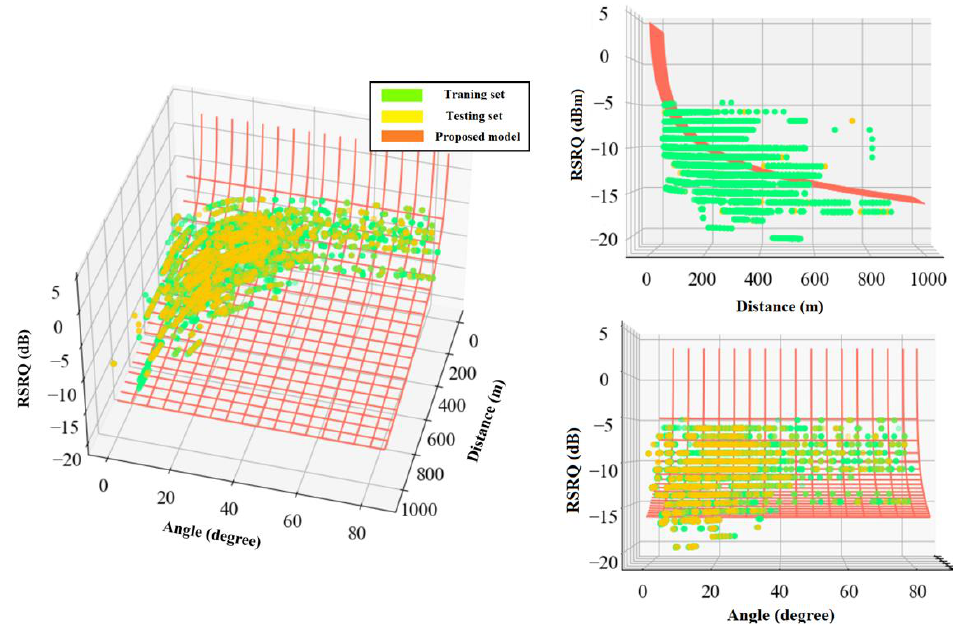
Figure 16. 3D representation of the proposed logarithmic model for RSRQ.